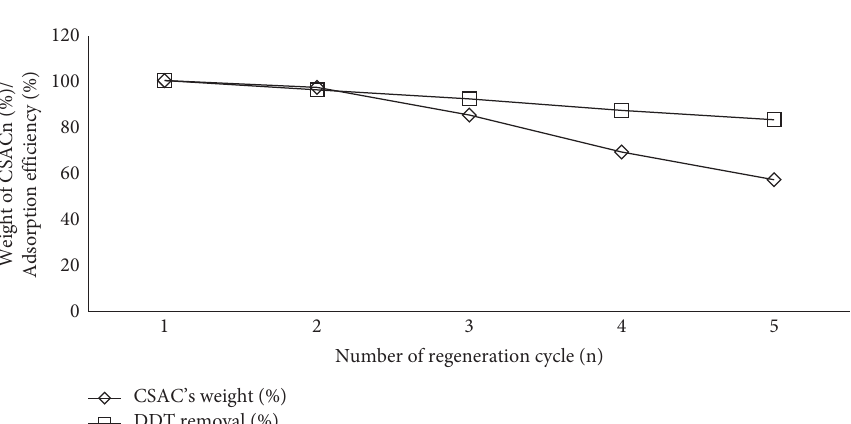
Figure 13: Regeneration plots of (a) DDT-CSAC ° C, adsorbate concentration of 10mg/L, n adsorption system (solution temperature of 30 adsorbent dose of 0.2g, solution volume of 200mL, and solution pH of 7).